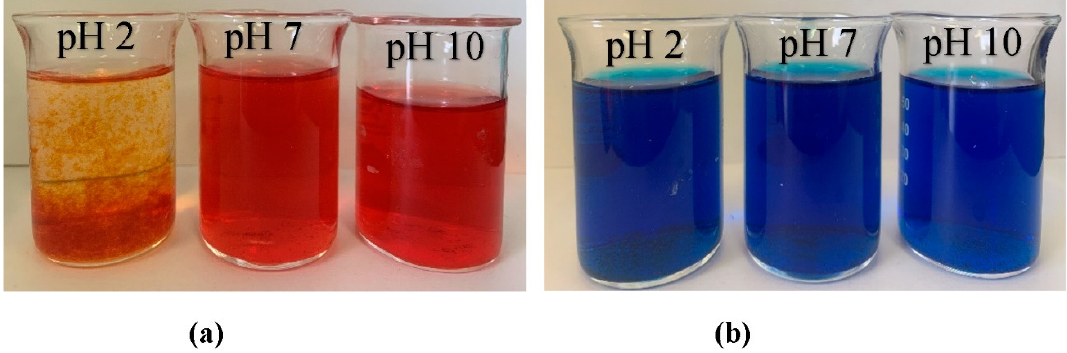
Figure 11. Photographs of dye solution after nitrate adsorption process (10 mg of ZLCH-Fe; initial NO 3 : 100 mg/L; initial dye: 25 mg/L; contact time: 5 min). ( a ) AR88; ( b ) MB.